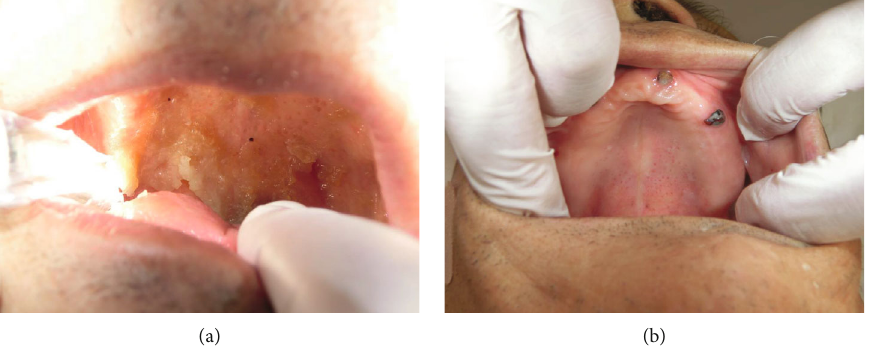
Figure 3: Oral condition at (a) initial dental examination and (b) after receiving professional oral health